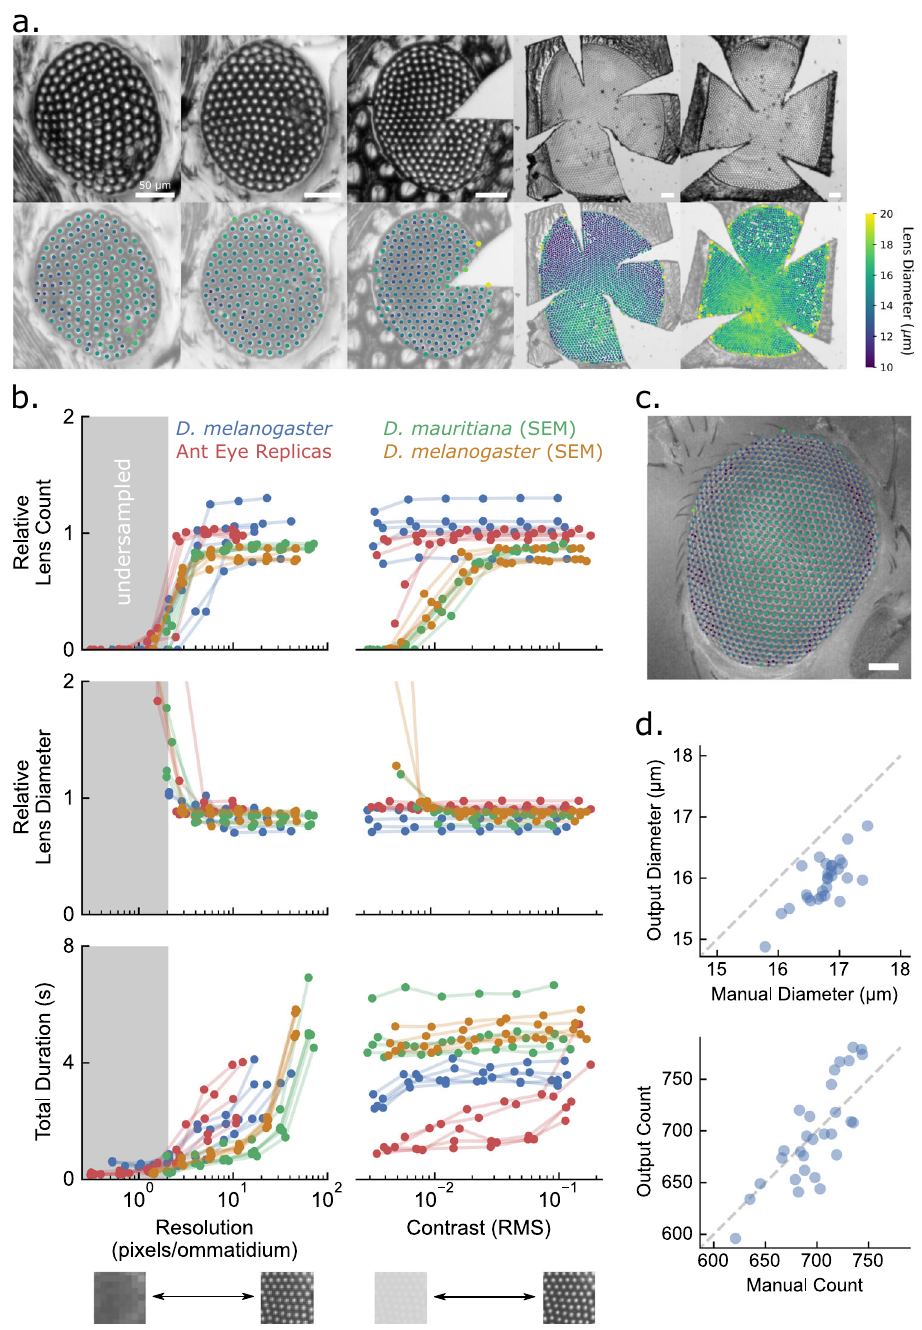
Fig. 2 The ODA successfully approximated ommatidial counts and diameters when compared to manual measurements. a Micrographs of ant eye molds (top) and their corresponding ODA results (bottom) with approximate lens centers colored according to their diameter. When applied to 5 ant eye molds of 4 species ranging in overall size and lattice regularity, the automated counts were 99% and the diameters were 93% of those measured by hand. For each image, the program missed relatively few ommatidia and the lens diameter measurements were successful even when they varied substantially within an image (as in #4 from the left). Species from left to right: Notoncus ectatommoides , Notoncus ectatommoides , Rhytidoponera inornata , Myrmecia nigrocincta , and Myrmecia tarsata . Scale bars are 50 µ m. b Benchmark performance of ODA on micrographs of diminished spatial resolution (left) and contrast (right). We present 3 performance metrics as a function of resolution and contrast: relative lens count equal to the ratio of automatic to manual ommatidia counts (top); relative lens diameter equal to the ratio of automatic to manually measured lens diameters (middle); and the total duration or runtime of the ODA (bottom). c An example fruit fl y eye ( D. melanogaster) micrograph with the automated ommatidia centers superimposed as points colored according to the measured diameter using the same colormap as in a. d A comparison of automated and manual measurements of lens diameter and count for 29 microscope images of fruit fl y eyes from the same species ( D. melanogaster ). Automated counts were 100% and the diameters were 95% of those measured by hand, with correlations of .81 and .76. Again, there were relatively low rates of false positives and